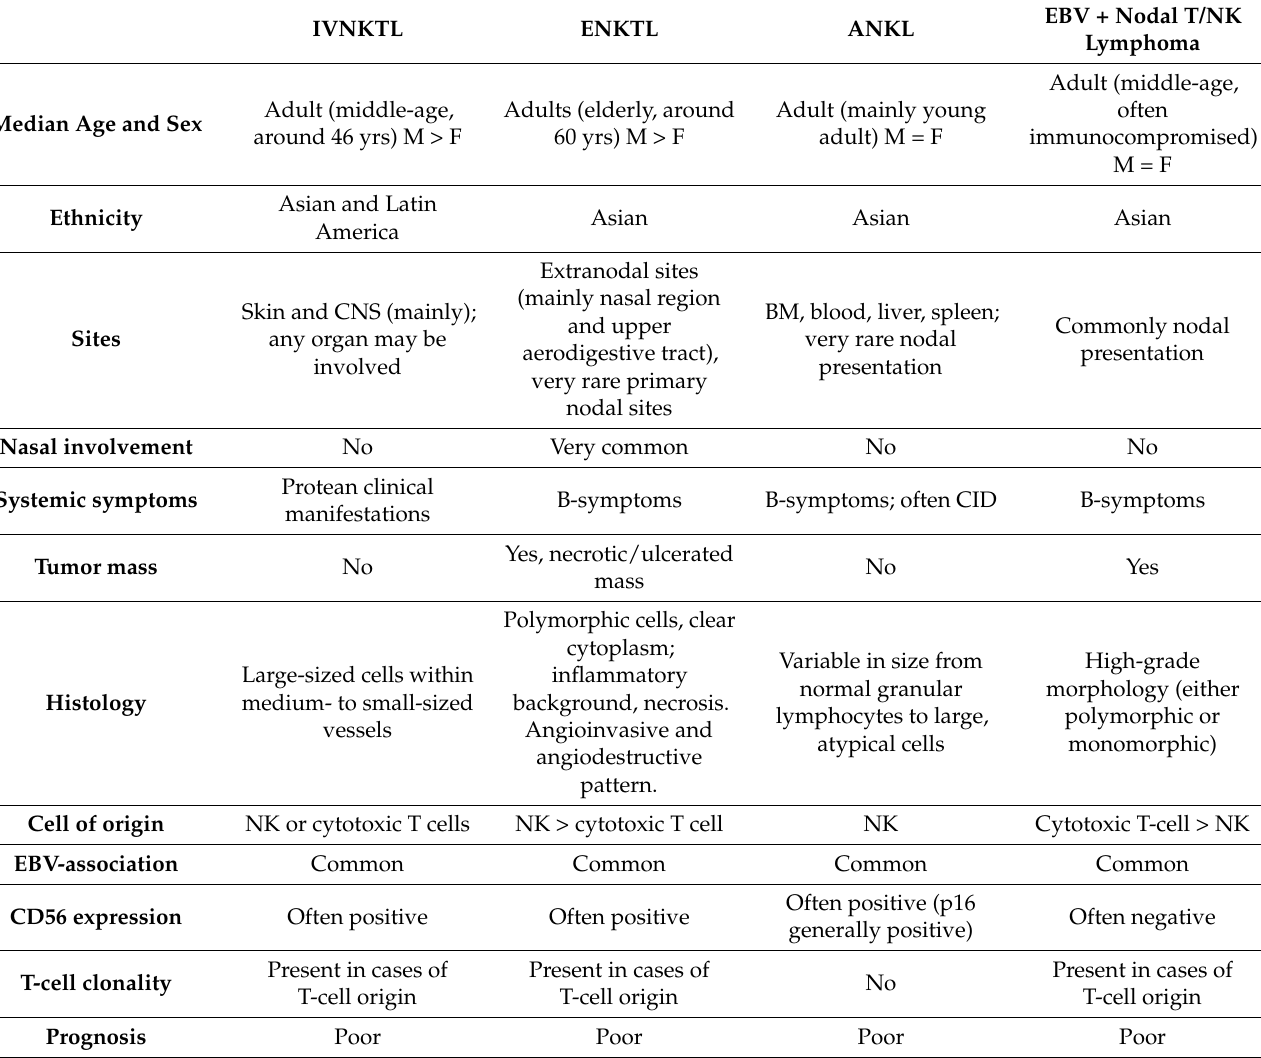
Table 1. Differential diagnoses of